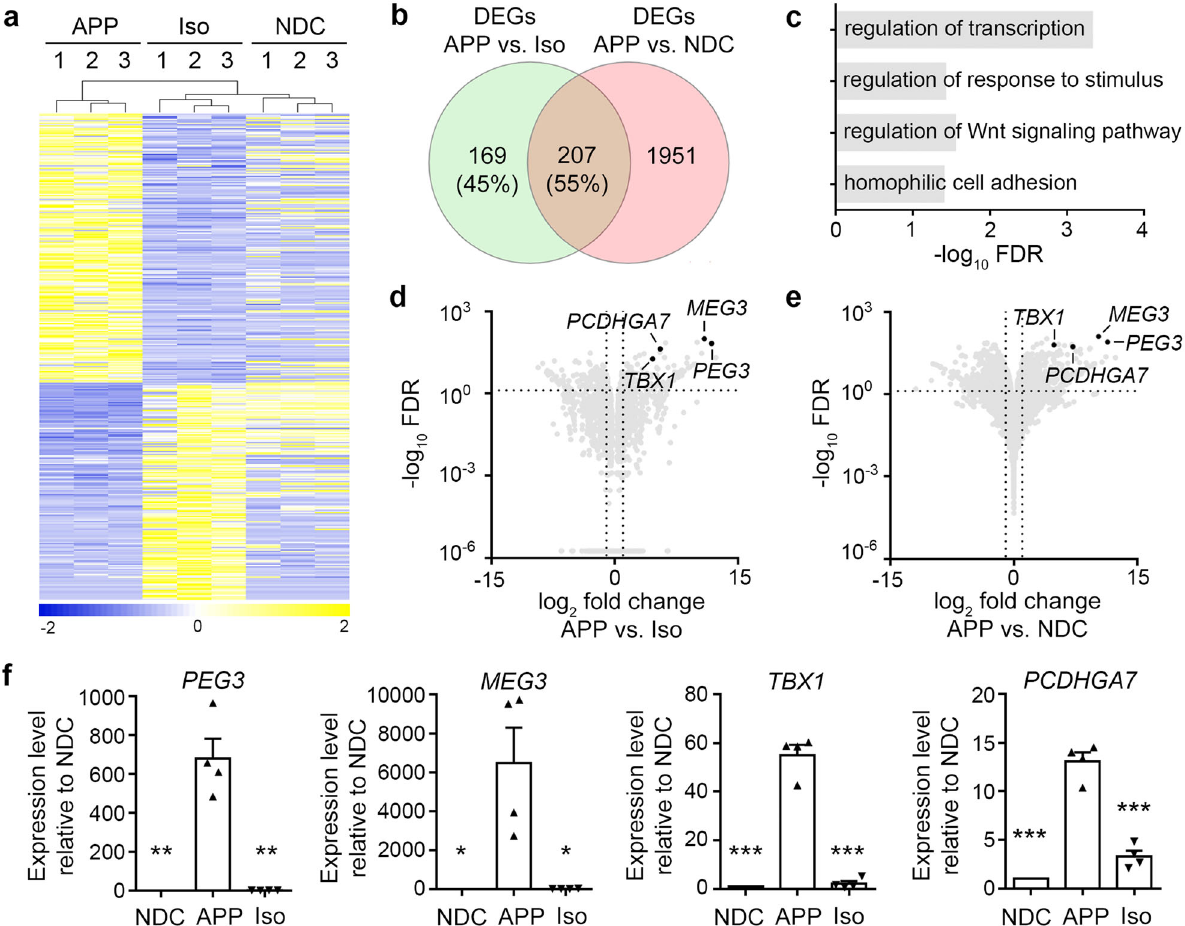
Fig. 3 Transcriptomic pro fi ling of isogenic induced pluripotent stem cell-derived neurons. a Hierarchical clustering analysis of the 376 differentially expressed genes (DEGs) in APP duplication parent (APP), APP copy number-corrected isogenic (Iso), and nondemented control (NDC) neurons. Among them, 208 and 168 genes were up and downregulated, respectively, in APP neurons compared to Iso neurons (false discovery rate [FDR] < 0.05, fold change ≥ 1.5). b Venn diagram illustrating overlap between isogenic DEGs (APP vs. Iso neurons) and non-isogenic DEGs (APP vs. NDC neurons) (FDR < 0.05, fold change ≥ 1.5). c Enriched Gene Ontology (GO) terms for the 207 common DEGs. Volcano plots showing the DEGs between the APP and NDC neurons ( d ) and between the Iso and APP neurons ( e ). Four selected genes upregulated in APP neurons compared to NDC neurons that were the top genes downregulated in copy number-corrected Iso neurons compared to APP neurons. f RT-qPCR validation of top DEGs common to both NDC and Iso neurons compared to APP neurons. Values are mean ± SEM ( n = 4 independent biological replicates per condition; * p < 0.05, ** p < 0.01, or *** p < 0.001 vs. APP neurons, Student ’ s t